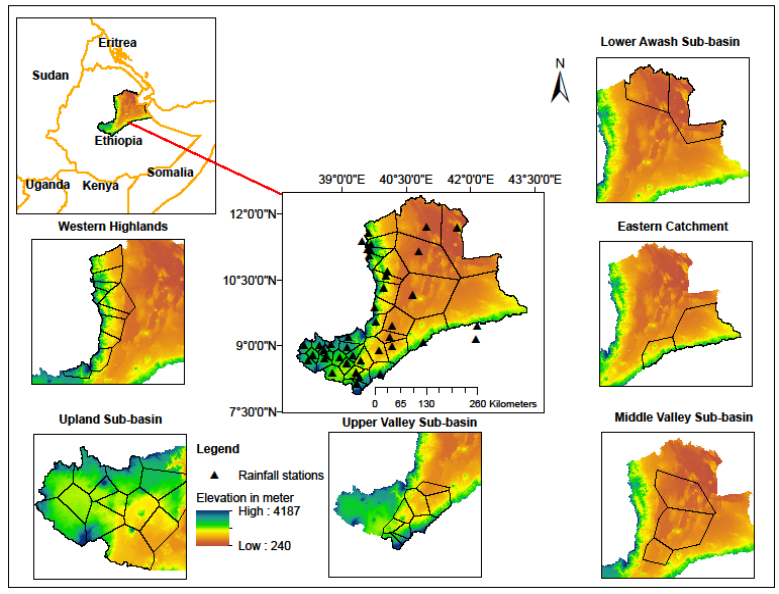
Figure 1. Location, elevation, and Thiessen polygon map of Awash River Basin (ARB), Ethiopia.